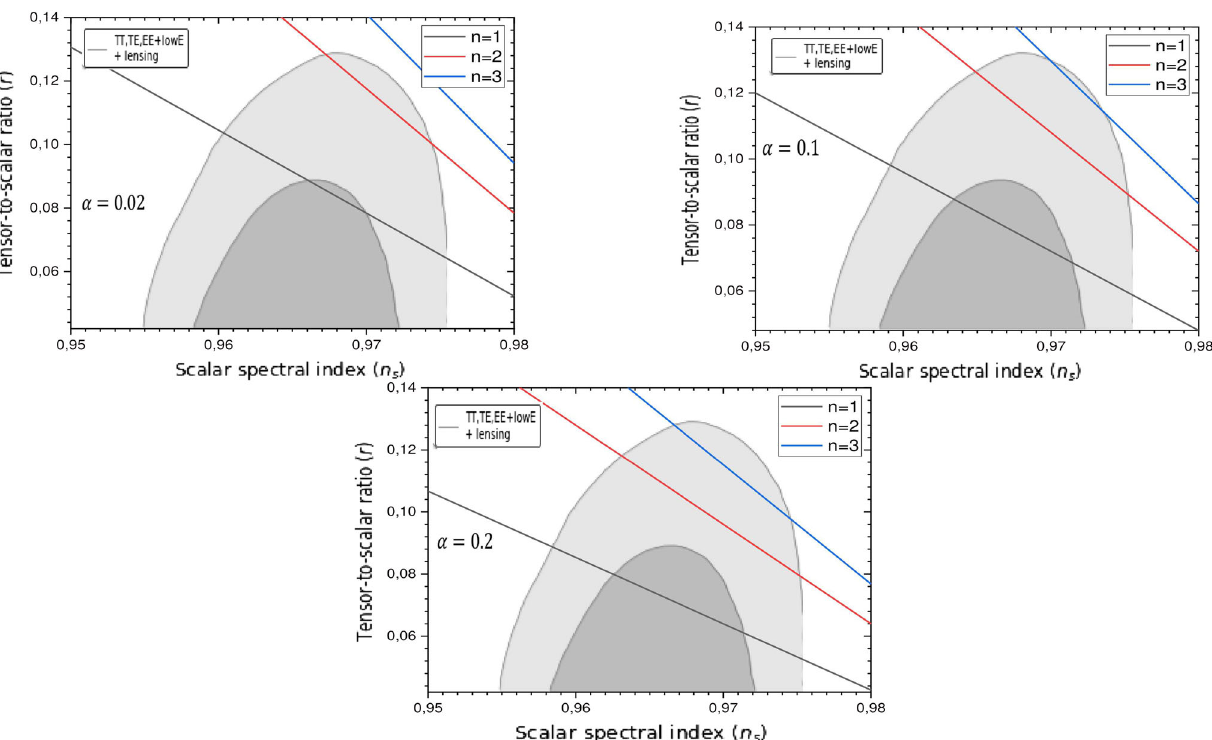
Fig. 1 r versus n s plot for monomial inflation with a Gauss–Bonnet coupling function. Inner and outer shaded regions are 1 σ and 2 σ constraints from Planck respectively. We choose three different values of n , for the black line n = 1, the red line represents n = 2 and for the blue line, n =